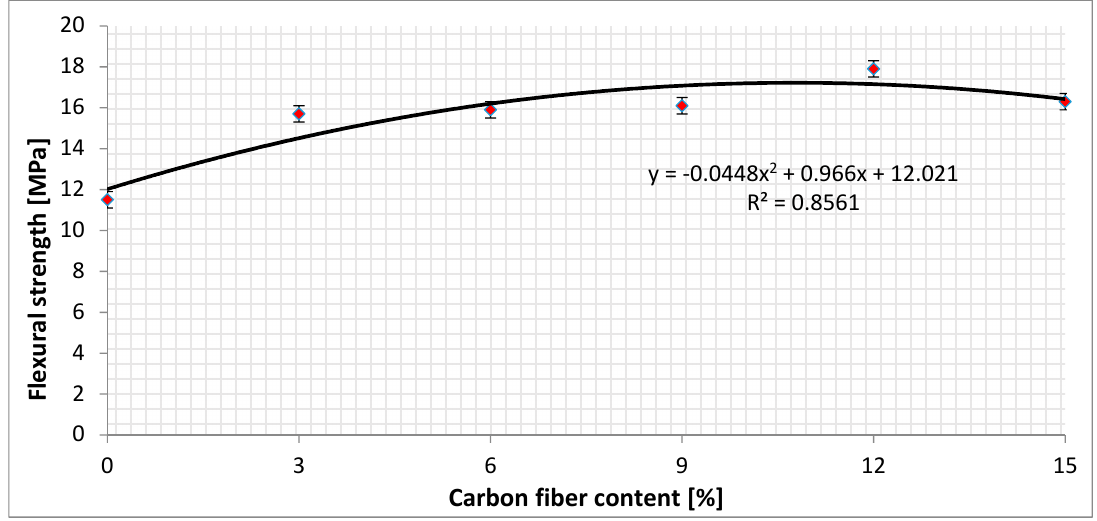
Figure 11. The graphical comparison of the effect of carbon fiber content on flexural strength.